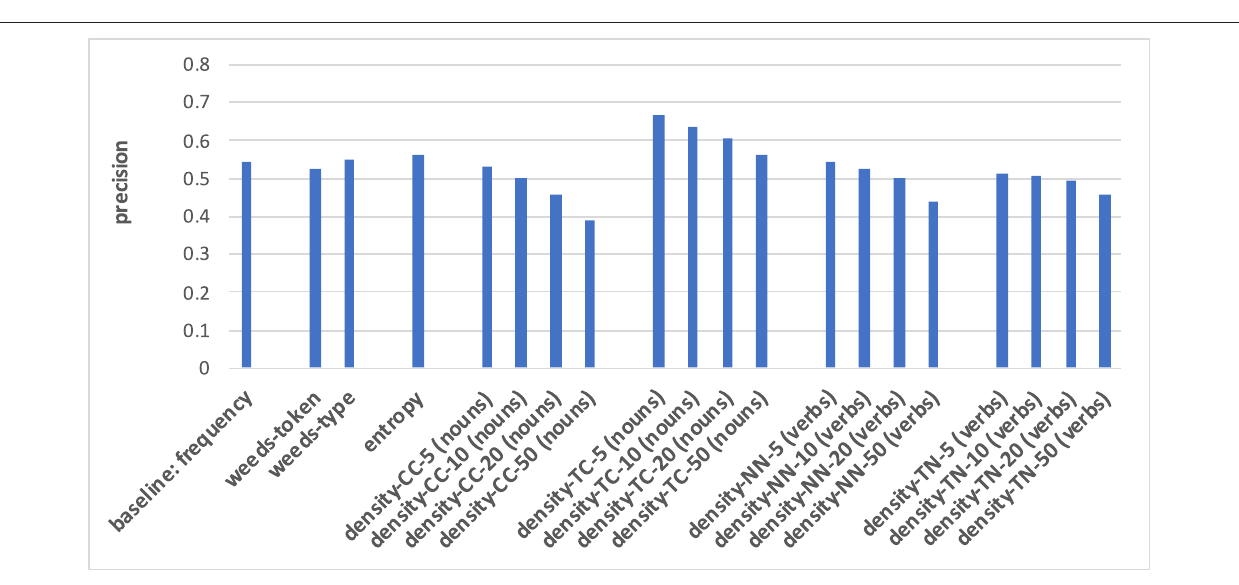
FIGURE 6 | Pair-wise precision results for concreteness of verbs relying on an N-V-A vector space. Densities take only nouns as context/neighbour words into